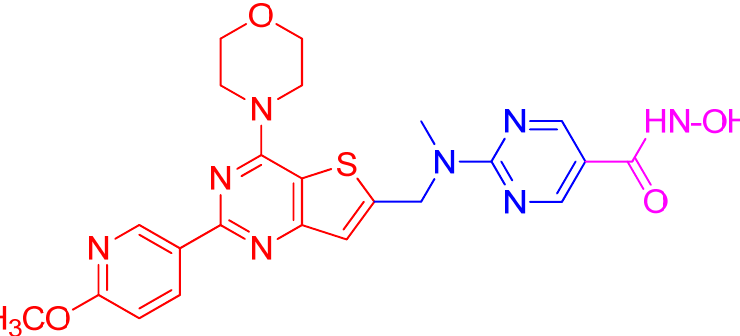
Figure 4. Structure of the HDAC / PI3K hybrid inhibitor CUDC-907. Hydroxamic acid moiety as the zinc binding functional group of HDACI (shown in magenta) is conjugated to morpholino- pyrimidine PI3K pharmacophore (shown in red) through a linker (shown in blue).